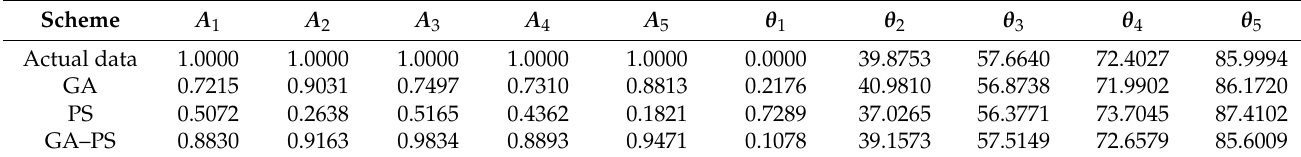
Table 9. Comparison of DOAs achieved using GA, PS, and